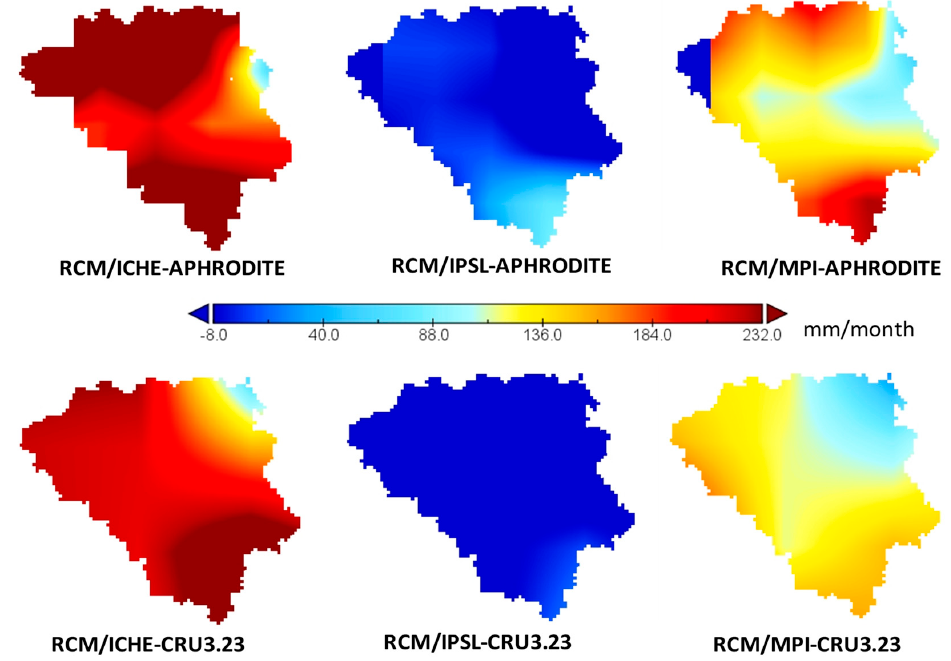
Figure 2. Spatial distribution bias of the precipitation simulations minus observations during 1986–2005 (mm/month).